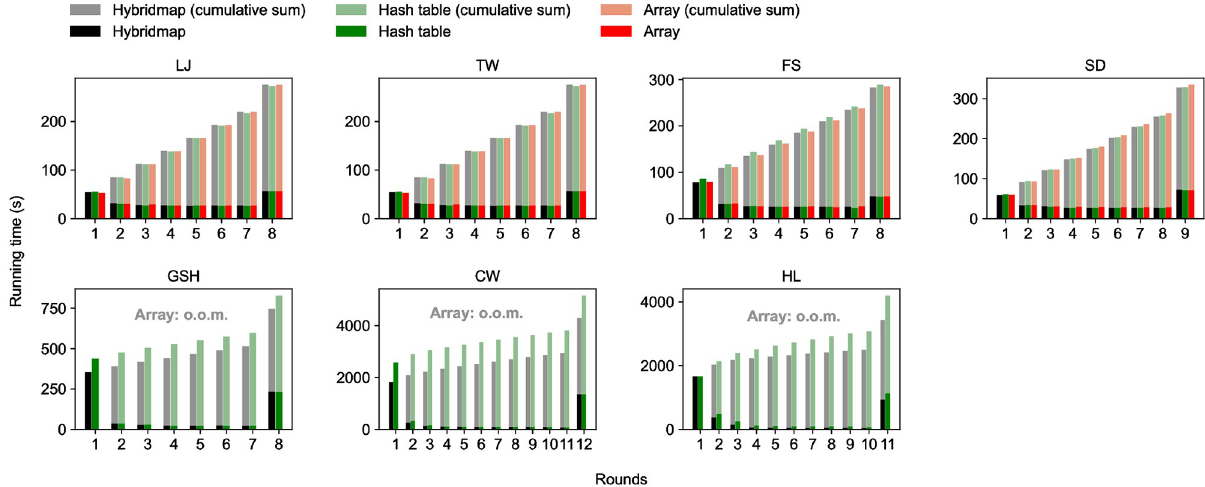
Fig 13. The running time of UniStar-opt with HybridMap, a hash table, and an array, respectively, each round. UniCon-opt with HybridMap outperforms Unicon-opt with hash tables when the graph is large enough (FS, SD, GSH, CW, and HL) thanks to fast random accesses of HybridMap. UniCon-opt with arrays fails on large graphs (GSH, CW, and HL) because of an out-of-memory error.